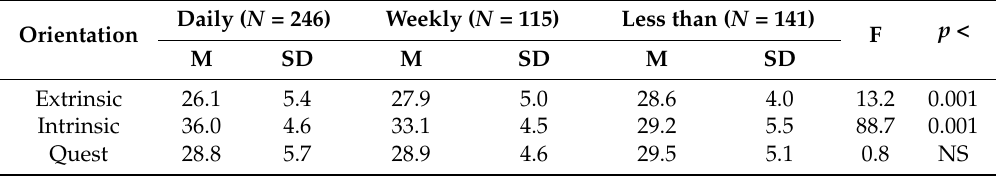
Table 3. Mean scale scores by personal